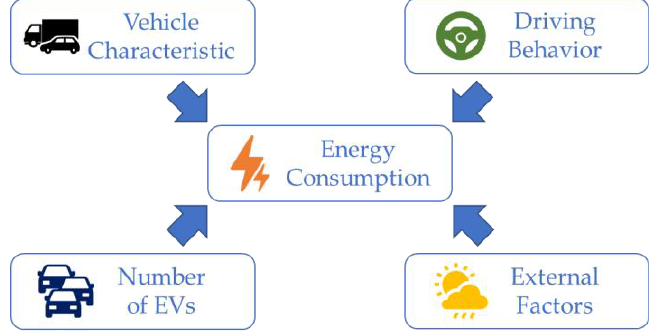
Figure 2. Concept of energy consumption estimation.